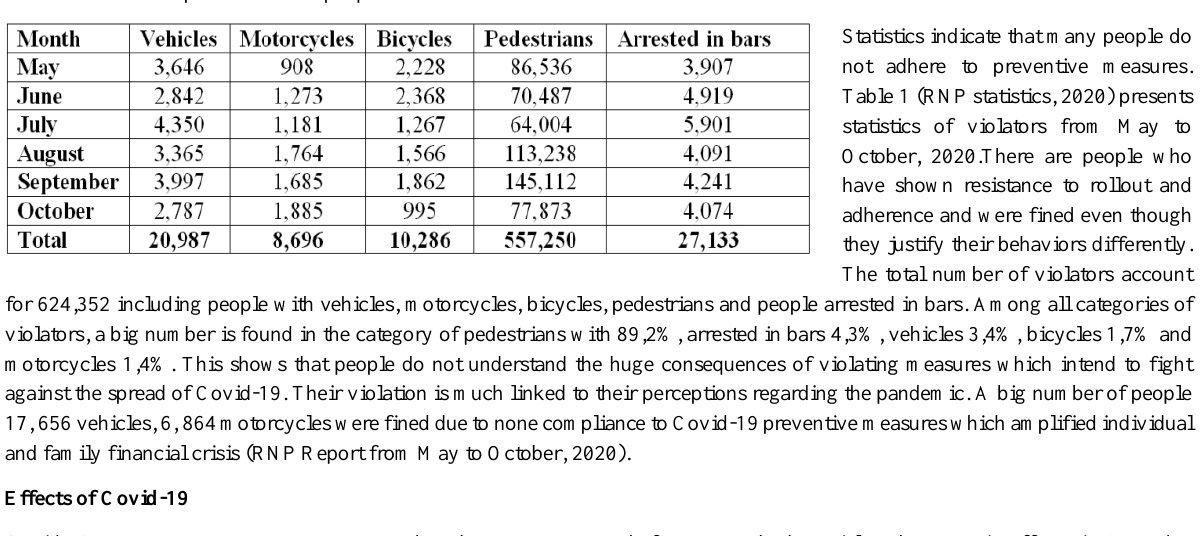
Table 1: Statistical presentation of people who violated Covid-19 measures